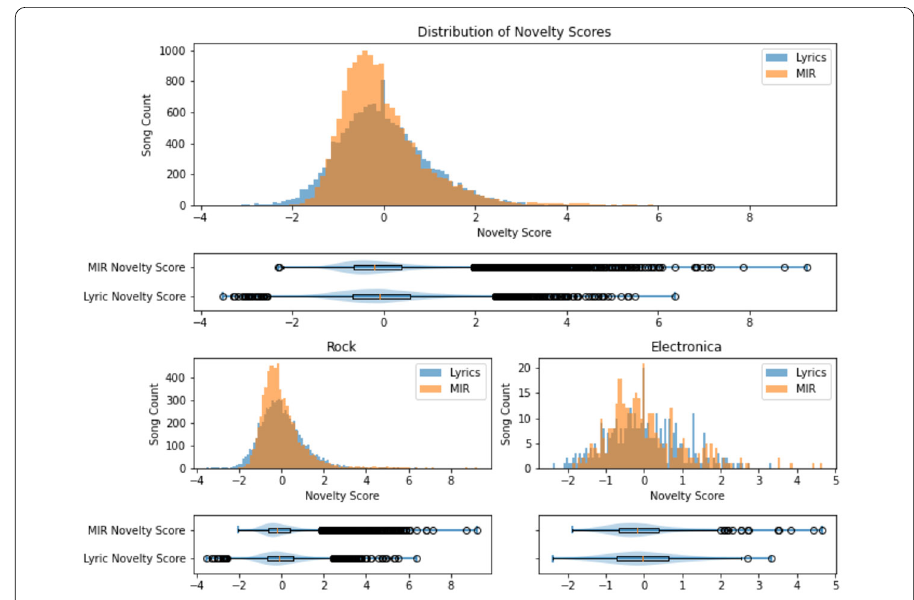
Figure 3 Distribution of MIR novelty scores and lyric novelty scores. Top plot displays the distributions for all songs within the dataset. The bottom two plots display the distributions for all songs within the Rock genre and Electronica genre, respectively